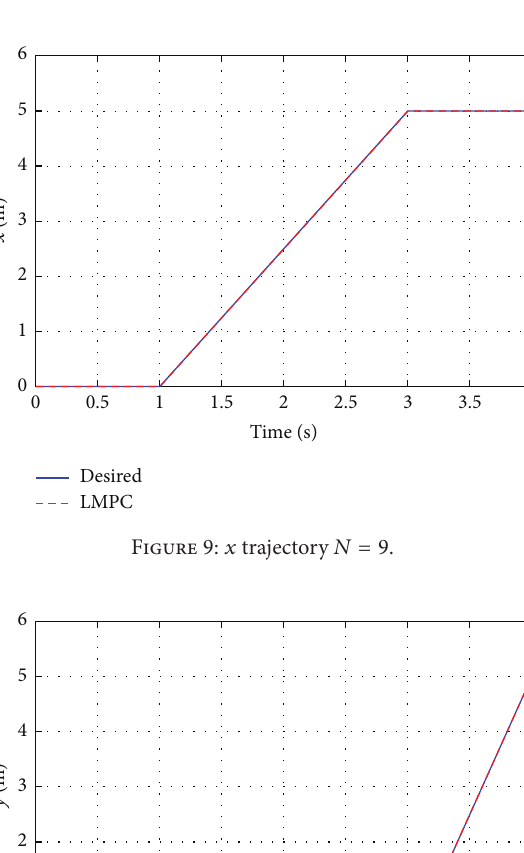
Figure 11: 𝑦 trajectory 𝑁 = 9 .